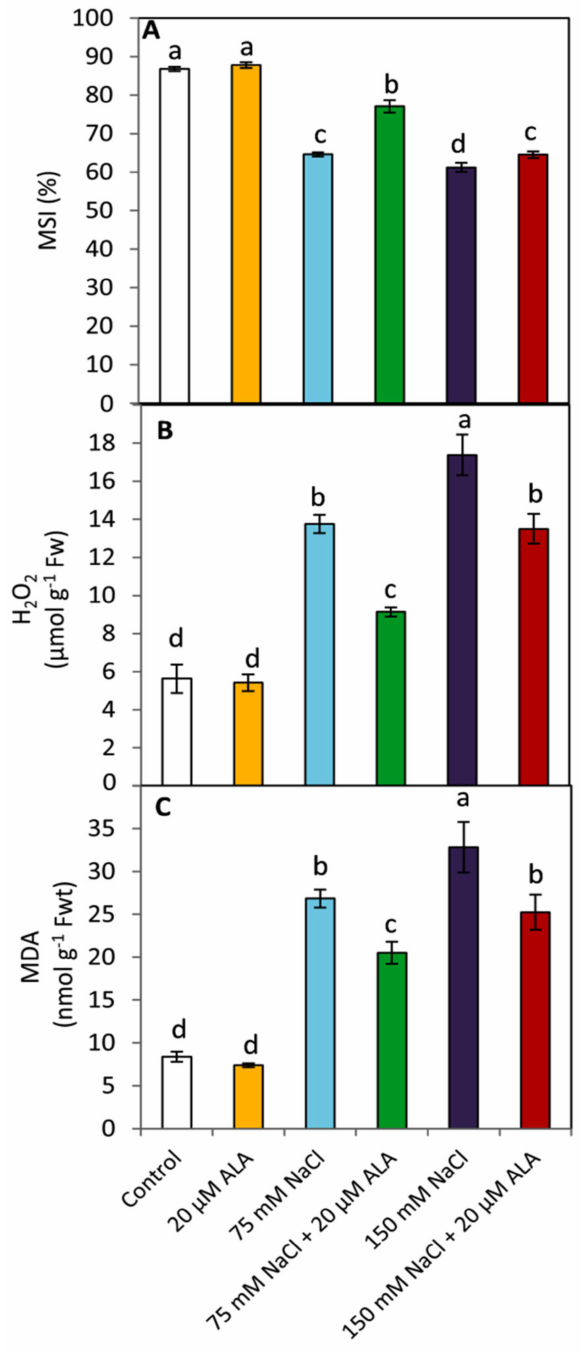
Figure 2. Effect of salinity stress as NaCl (0, 75 and 150 mM) and the foliar application by α -lipoic acid (ALA; 0 and 20 µ M) on ( A ) membranes stability index (MSI), ( B ) H 2 O 2 and ( C ) malondialdehyde (MDA) of sorghum plants. For each parameter, the mean values ± SD followed by a different letter are significantly ( p ≤ 0.05) different according to Tukey’s range